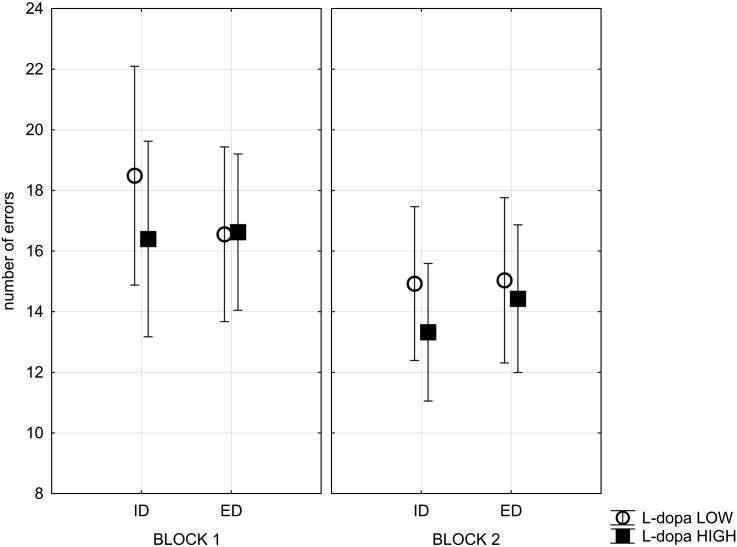
Effects ofl-dopa on error rate. This figure illustrates the effects of l-dopa dose on the mean number of errors per type of target change (ID or ED) for both the first and the second block of the task. Significant predictor l-dopa dose was broken down by median-split for visualization purpose only. Bars represent standard error of the mean.